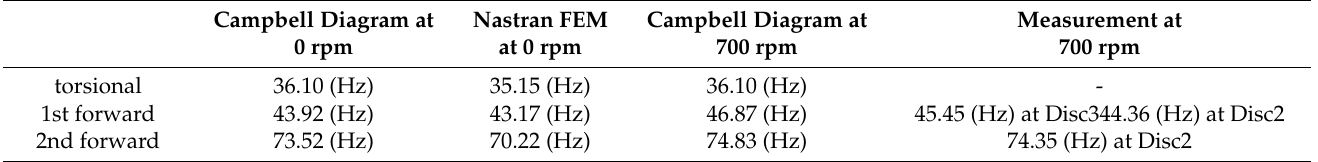
( b ) Figure 12. First order tracking of response, ( a ) measurement data test-b, ( b ) test-a. Figure 12b shows the peak of the vibration at the first order, the 1X component of test-b appears at 400 rpm. The rotating speed in the case of test-a has been changed very quickly and has large fluctuation; the peak is visible at a slightly higher speed of 450 rpm (Figure 12a). The peak of frequency at the 1X component of the signal is close to the 200